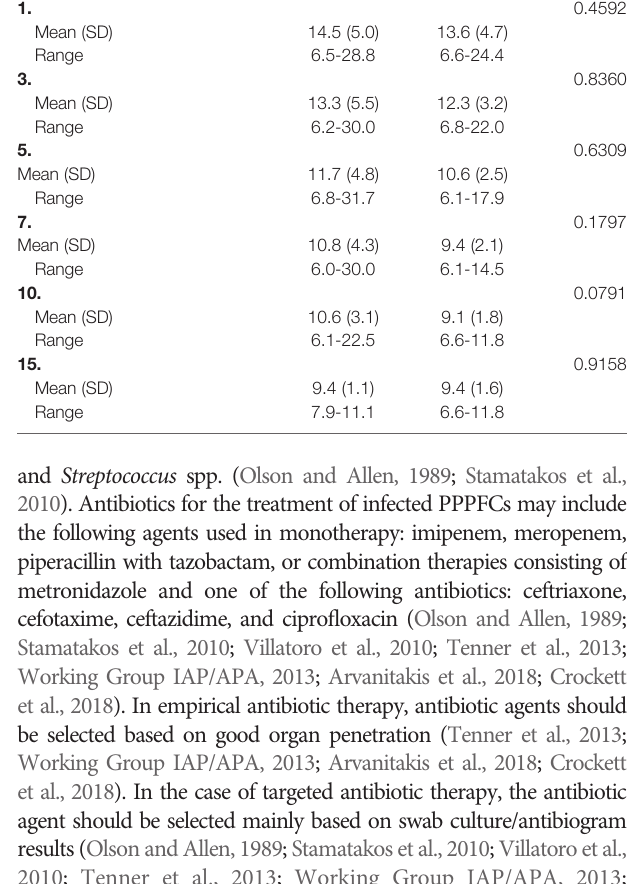
TABLE 6 | Comparison of the results of leukocytes (mm 3 ) in groups of patients during endotherapy. Day of endoscopic drainage Group 1 Group 2 p -value